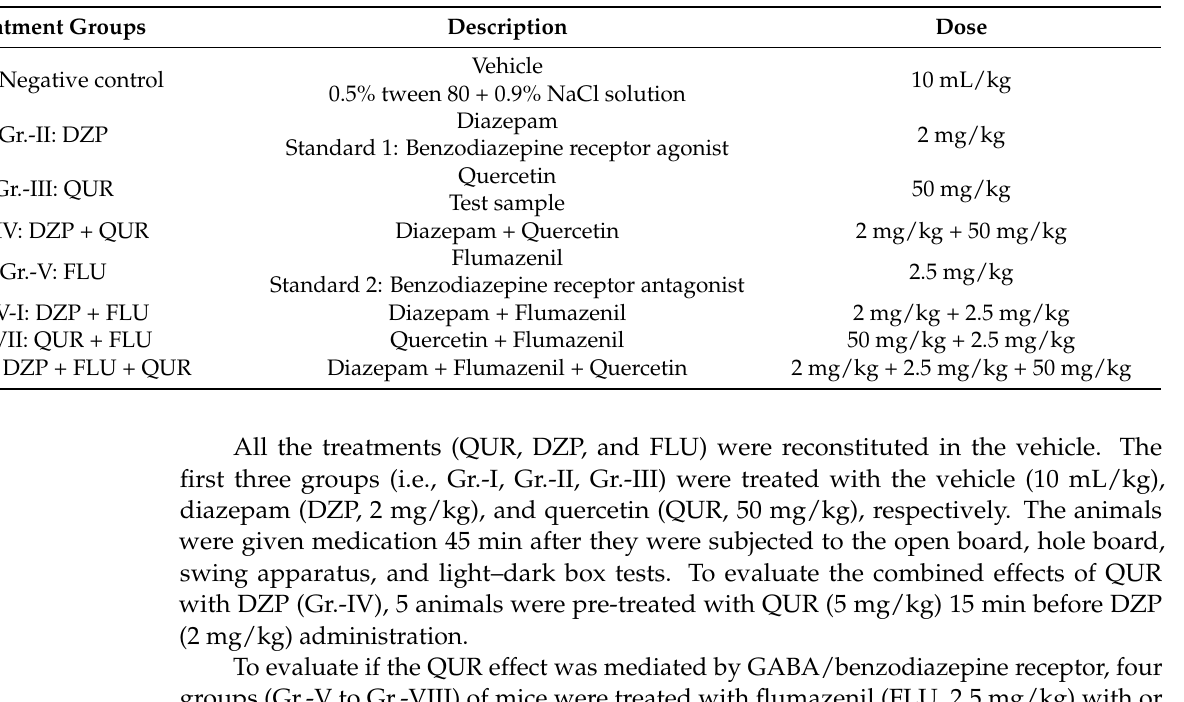
Table 9. Groups treated intraperitoneally in Swiss mice (n =